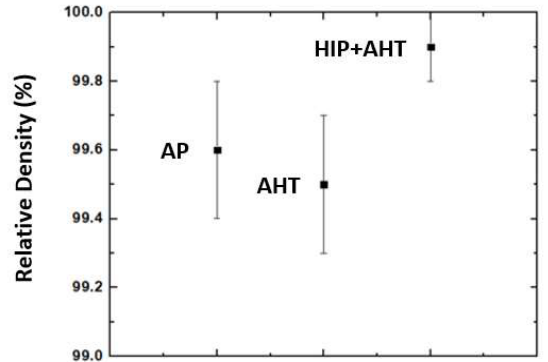
Figure 2. The measured relative densities from the optical micrographs reveal that the hot isostatic pressing (HIP) + annealing heat-treated (AHT) sample has the highest relative density. (n = 5).